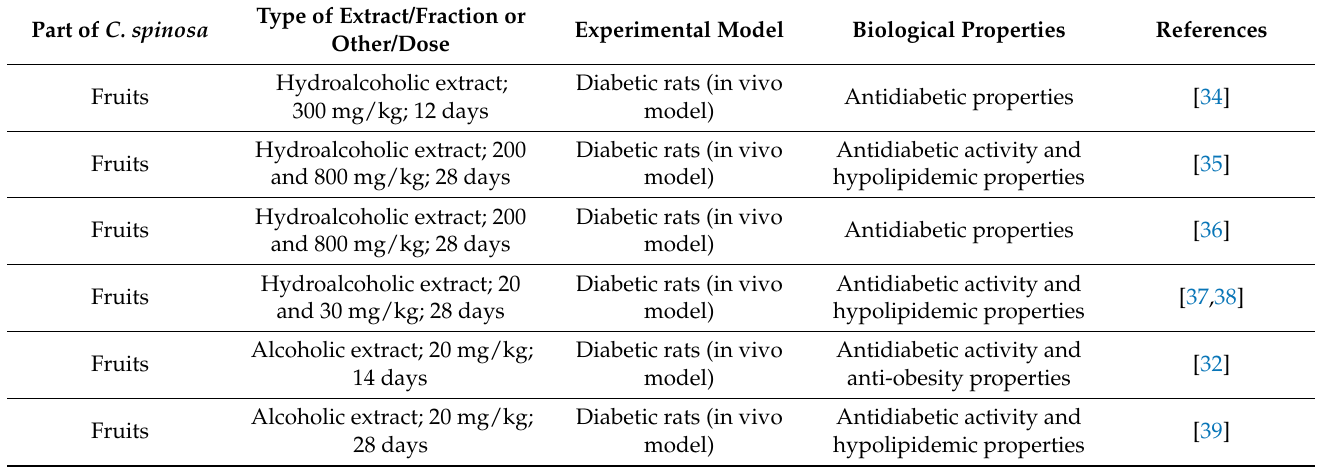
Table 1. Biological properties of different parts (fruits, leaves, roots, seeds, and buds) of C. spinosa in in vitro and in vivo